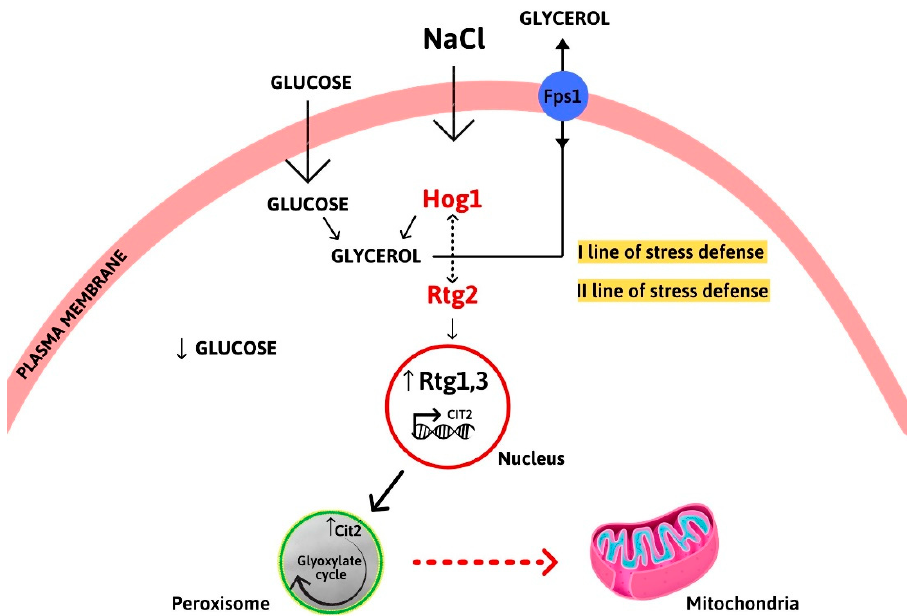
Figure 7. Interplay between HOG1 and the RTG pathway in osmoadaptation. Hog1 is activated by osmostress to promote glycerol biosynthesis as a rapid and transient cellular stress response. Intracellular glycerol accumulation is controlled by its own synthesis and by the aquaglyceroporin Fps1p. RTG signaling is activated in a later phase, as determined by CIT2 up-regulation, to sustain mitochondrial function and metabolic homeostasis for cellular adaptation.